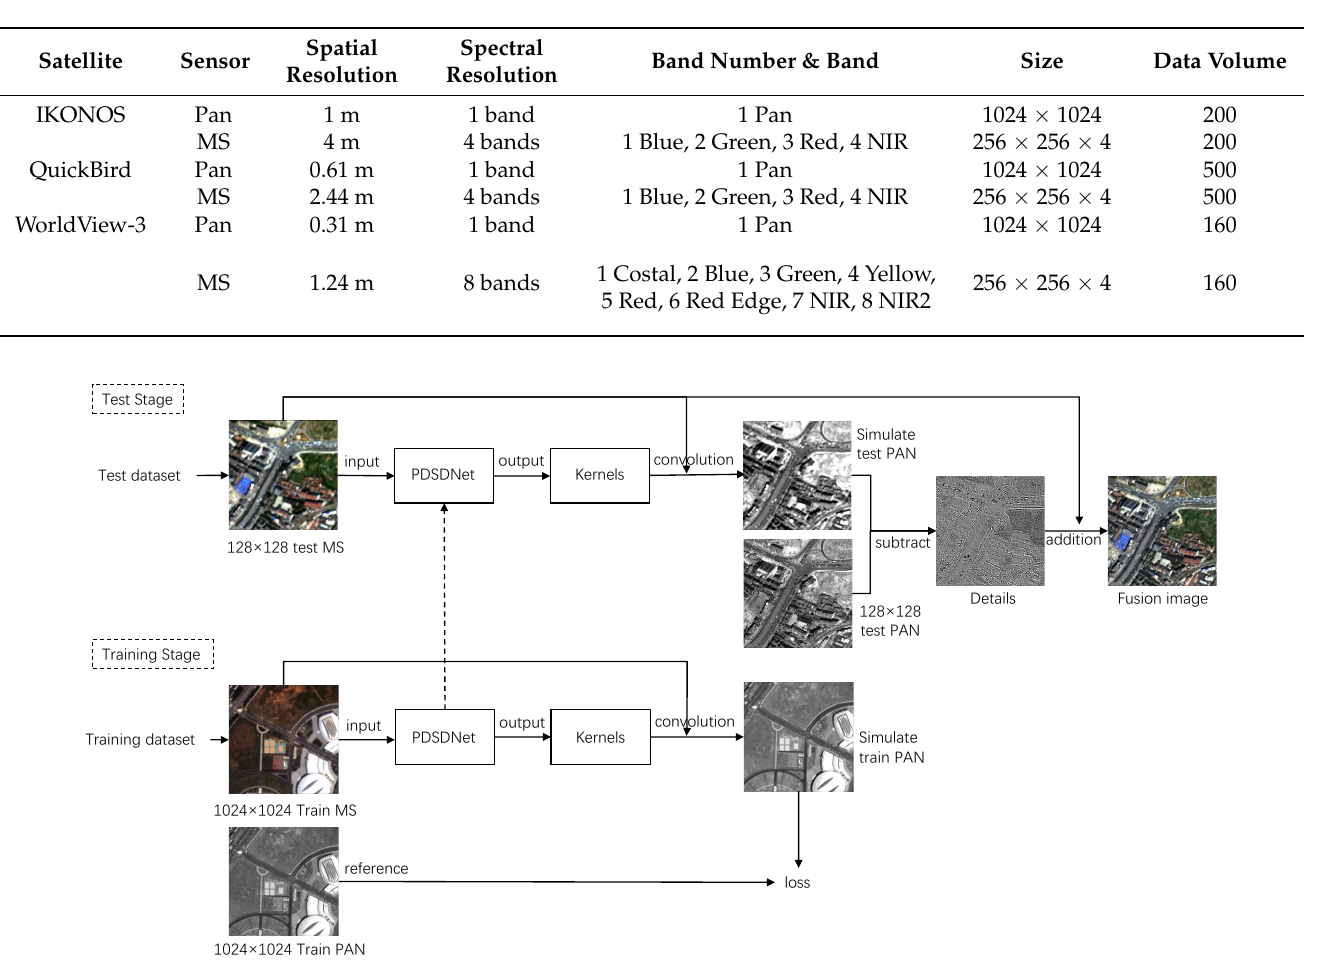
Table 1. Details of datasets.